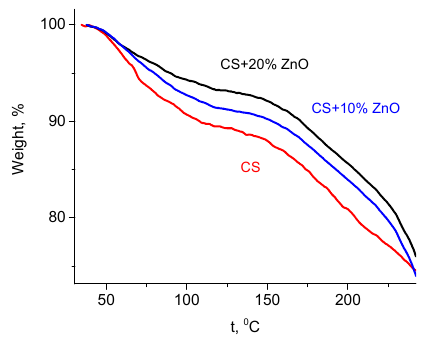
Figure 3. TGA measurements of pure CS and CS-ZnO NPs films with 10 and 20 wt.% of NPs.